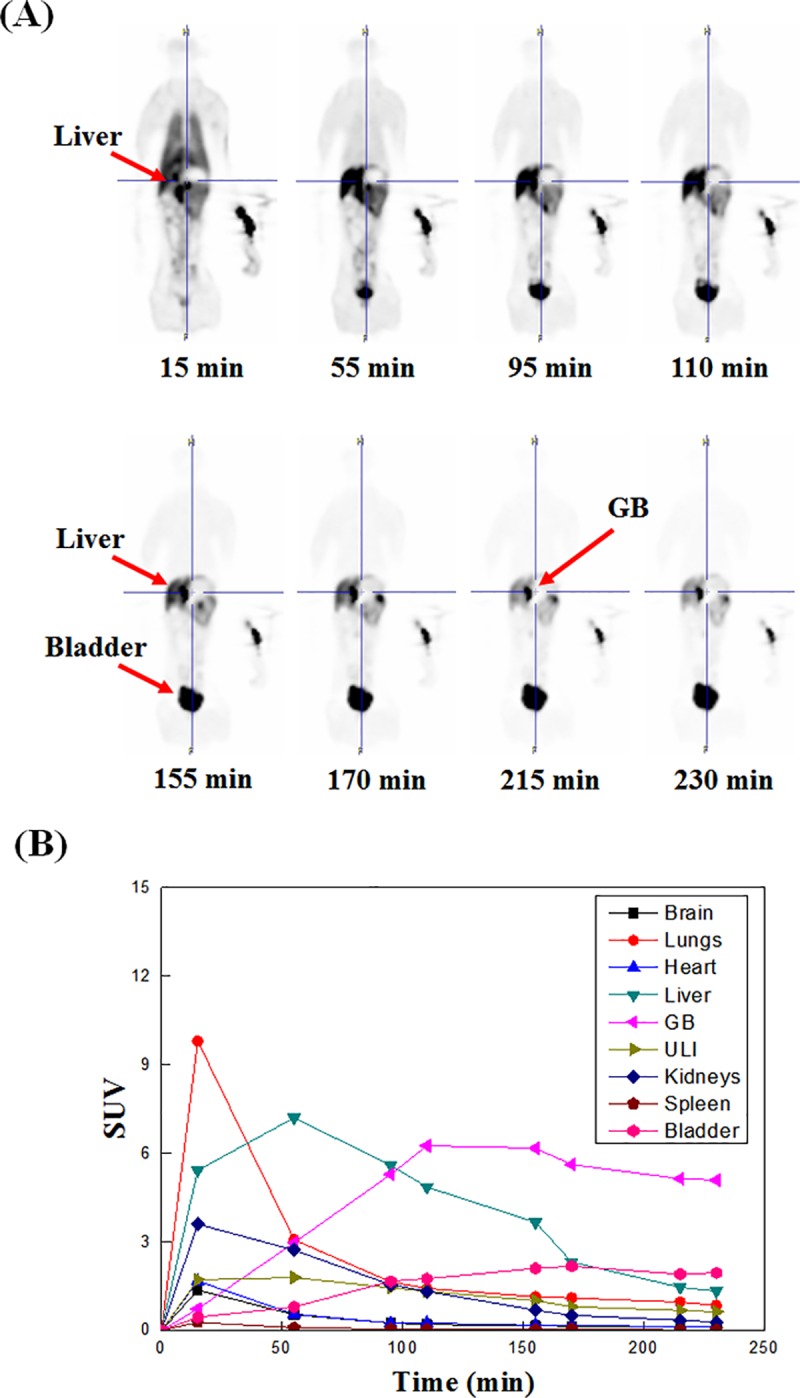
Typical sagittal view of [18F]T807 whole-body images of a male Formosan Rock monkey at different time points (A) and Non-decay-corrected time-activity curves of [18F]T807 in various organs of monkeys (n = 2) (B).